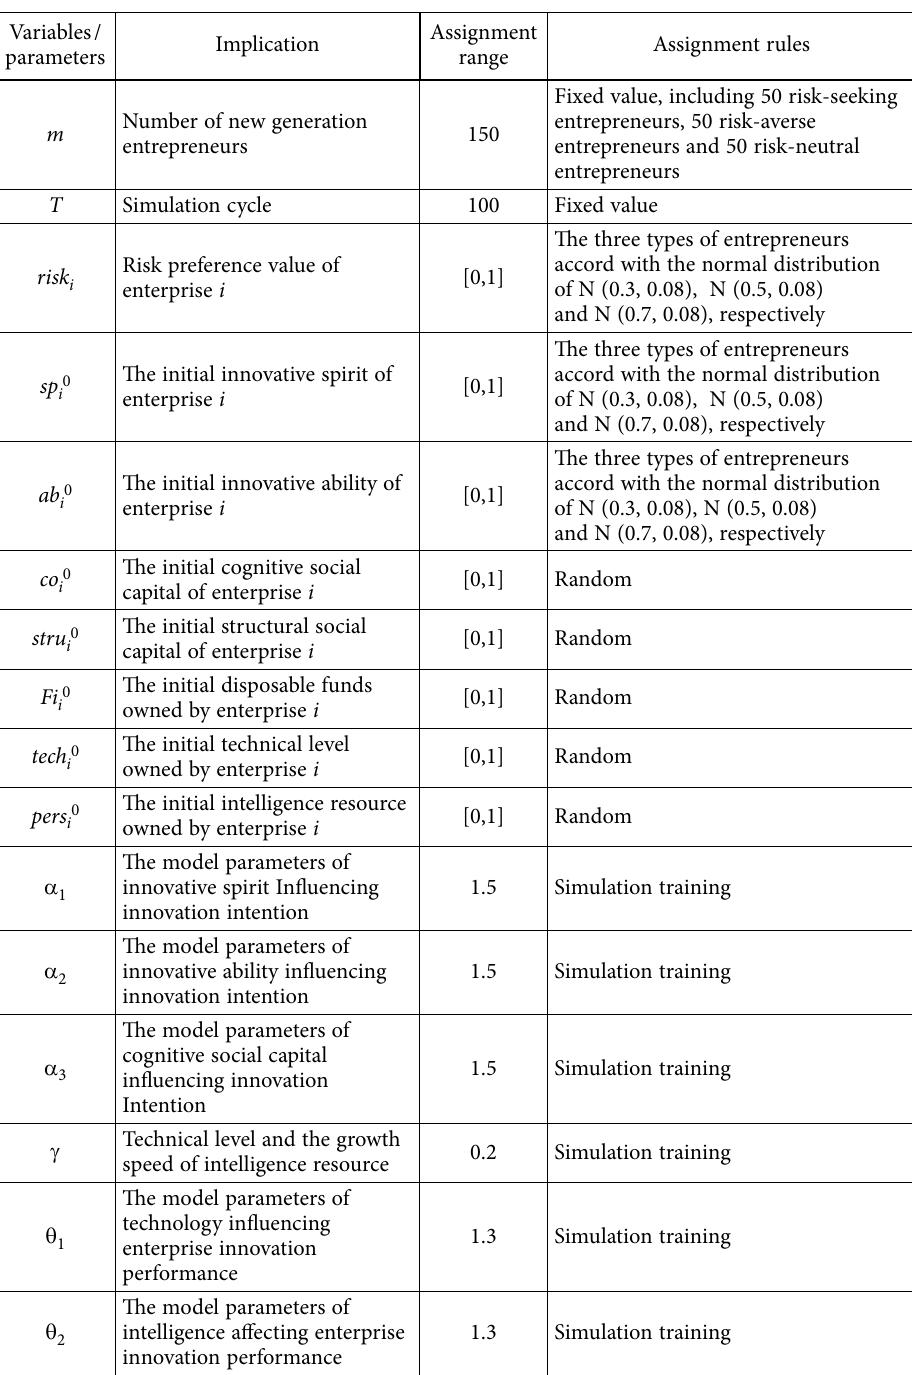
Table 1. Main variables and table of initial assignment rules Variables /